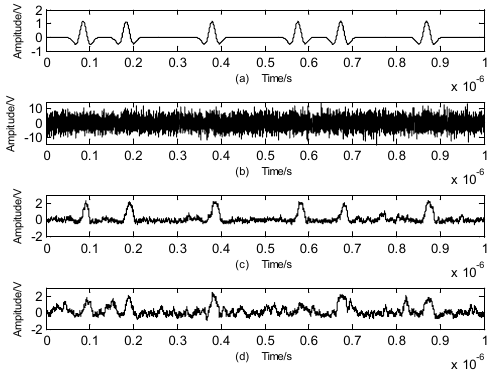
Fig. 5 Comparison of detection result Fig.5(a) is the original UWB-IR signal, Fig. 5(b) is the UWB-IR signal when SNR is -21.5dB, Fig.5(c) is the signal reconstructed waveform detected by wavelet packet and FHN model, Fig5(d) is the